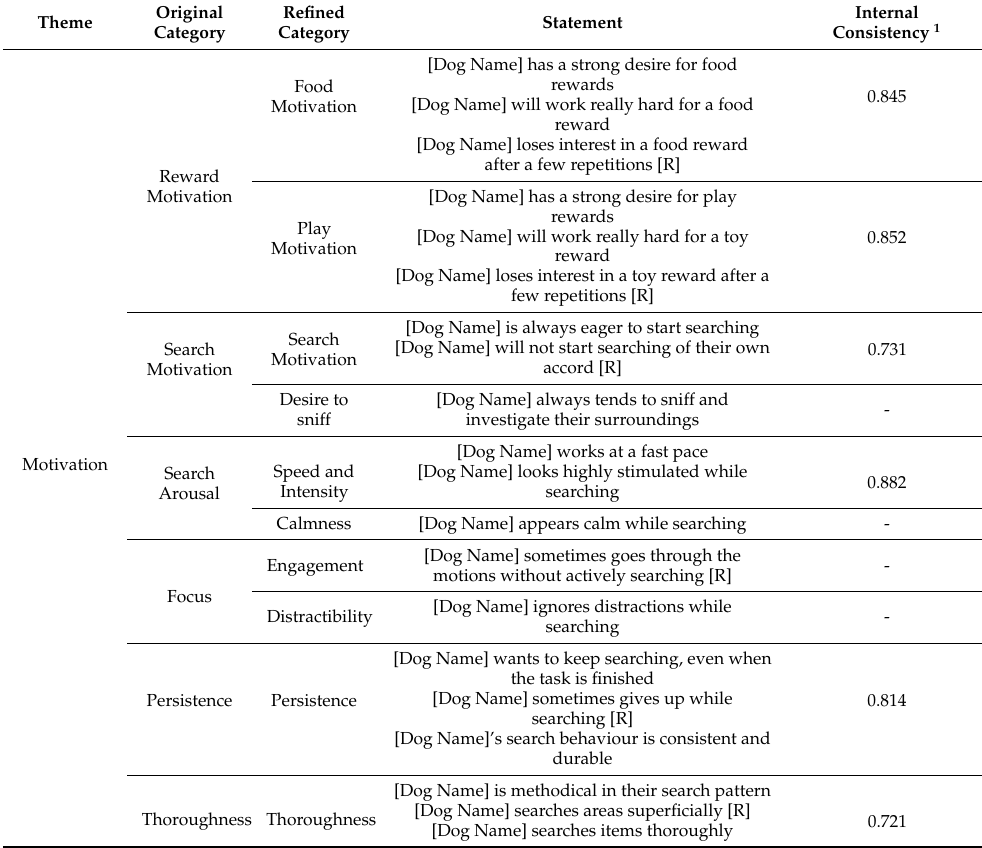
Table 2. Statements included for each construct in the work behaviour questionnaire with the overarching themes, coded categories, and subsequently refined categories. [R] indicates the items that were